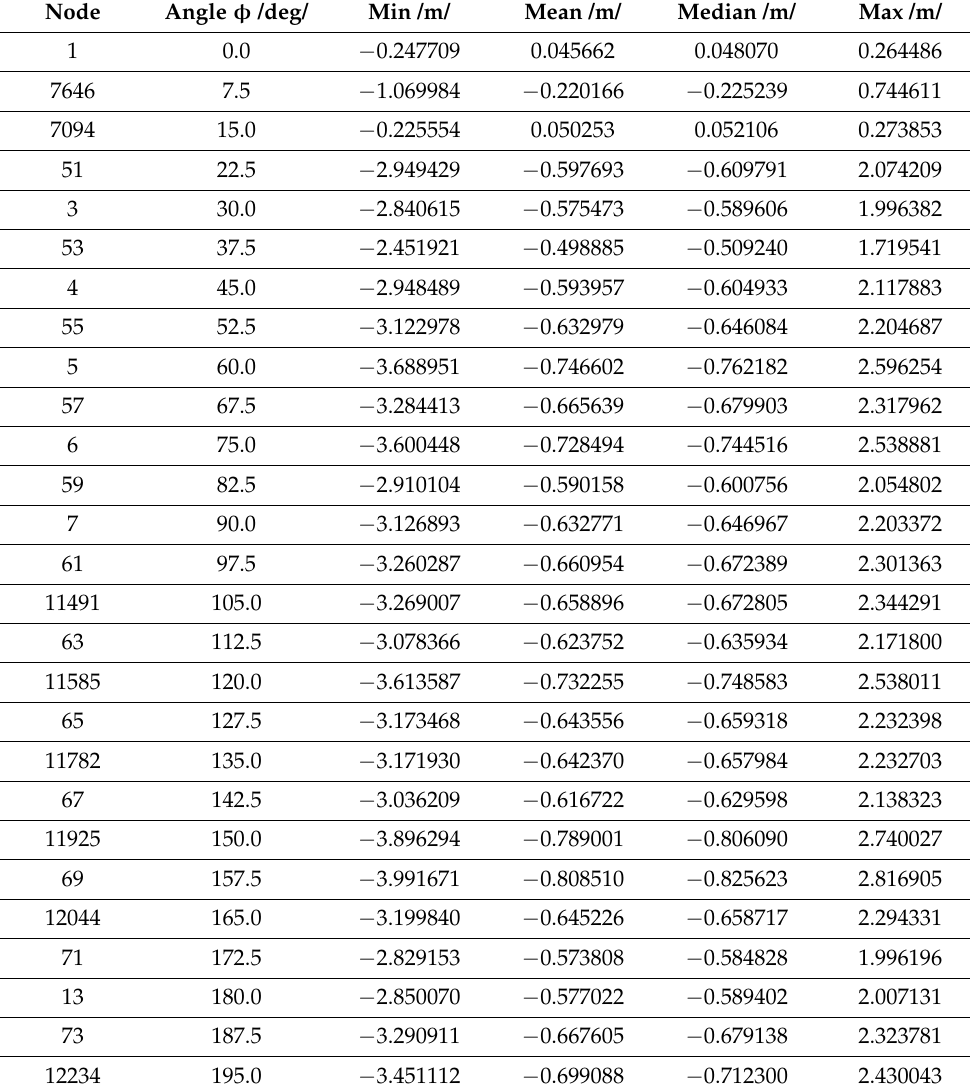
Table 3. Statistical parameters of radial